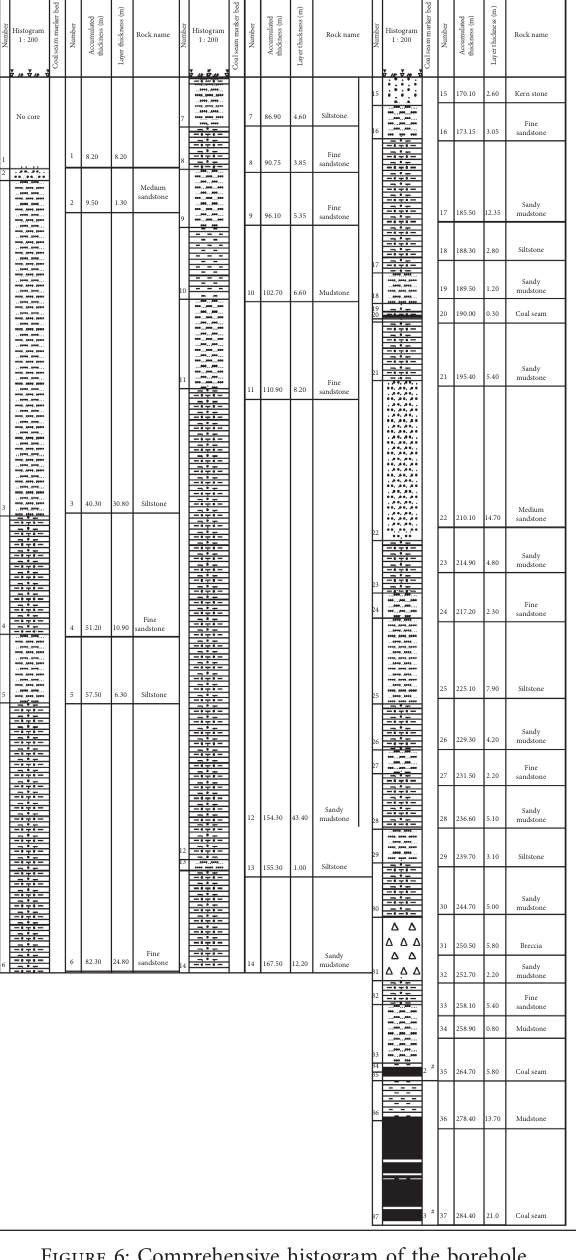
Figure 6: Comprehensive histogram of the borehole.